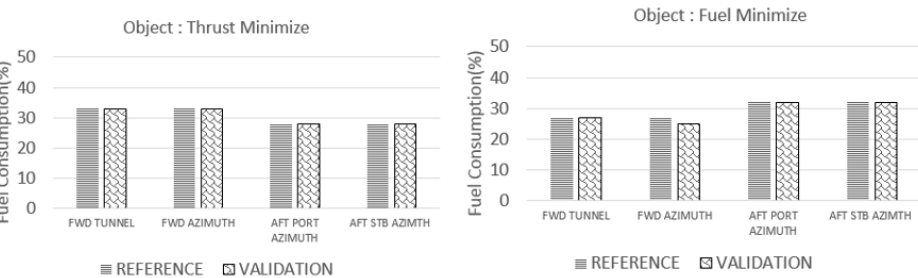
Figure 6. Thrust-Allocation Validation Results.